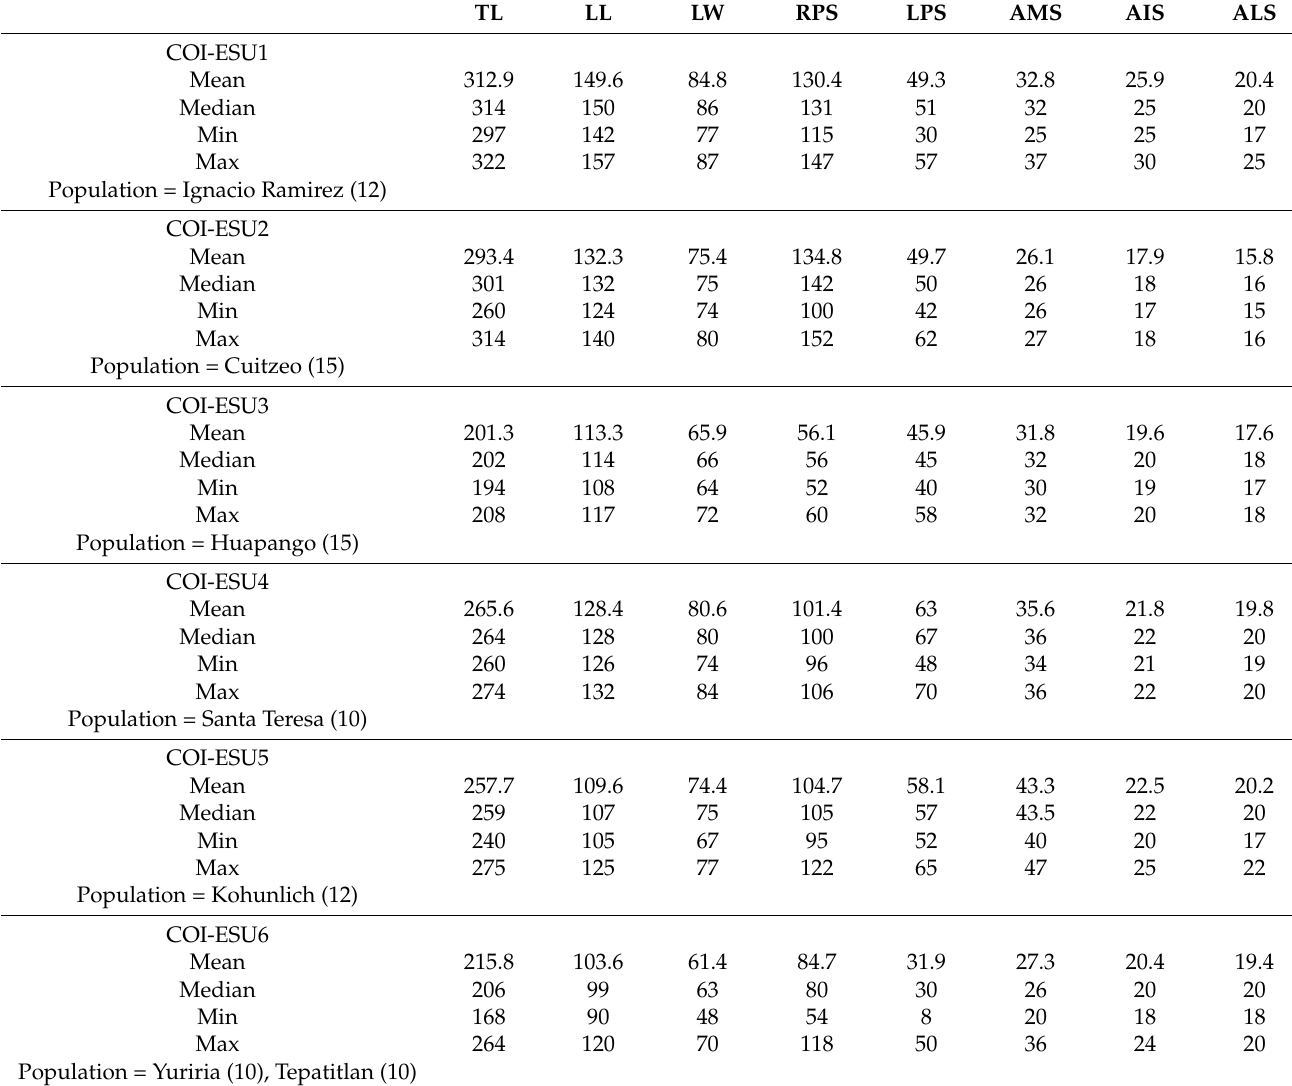
Table 1. Length measurements of main lorica features based on 84 specimens of Keratella taxa. Measurements were obtained by population, which match with the COI-ESUs. Total length (TL), lorica length excluding anterior and posterior spines (LL), lorica width at its widest part (LW), right posterior spine (RPS), left posterior spine (LPS), anteromedian dorsal spine (AMS), anterointermediate dorsal spine (AIS), anterolateral dorsal spine (ALS). Number of individuals measured is given between brackets. TL LL